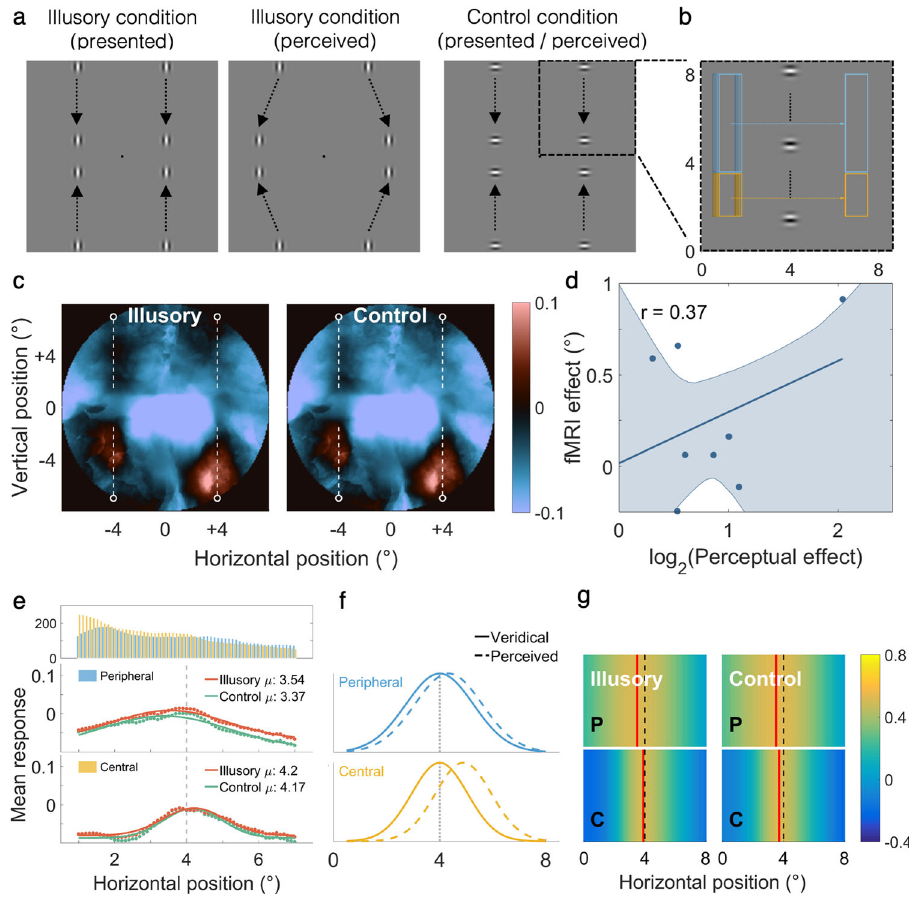
Fig. 2 Stimuli and group-level data for the Curveball experiment ( n = 10). a Gabor patterns in the illusory and control conditions travelled the same physical path. However, in the illusory condition, the internal gratings drifted in the direction orthogonal to the external path (towards the periphery); causing the perception of a ‘ curveball ’ when viewed in the periphery. b Sliding window sampling was used at the peripheral (blue) and central (yellow) location, corresponding to the start and the end of the motion path, respectively. Window height accounted for cortical magni fi cation. c V1 responses reconstructed in visual fi eld. Red and blue denote positive and negative responses relative to baseline, respectively. White dashed lines denote the physical motion paths. d Individual fMRI effects (de fi ned as illusory μ – control μ in the central location) plotted against perceptual effects. The shaded region denotes the 95% CI estimated through bootstrapping. e Group-level neural signatures collapsed across hemi fi elds and fi t with a Gaussian function. Both illusory and control signatures across both sliding window locations were centred on the physical motion path (vertical dotted lines). f Predicted neural signatures for simulated physical motion trajectories were correlated with the measured signatures. g Heat map showing correlation coef fi cient across various simulated physical motion paths. The best correlated (red line) signatures corresponded to the physical motion